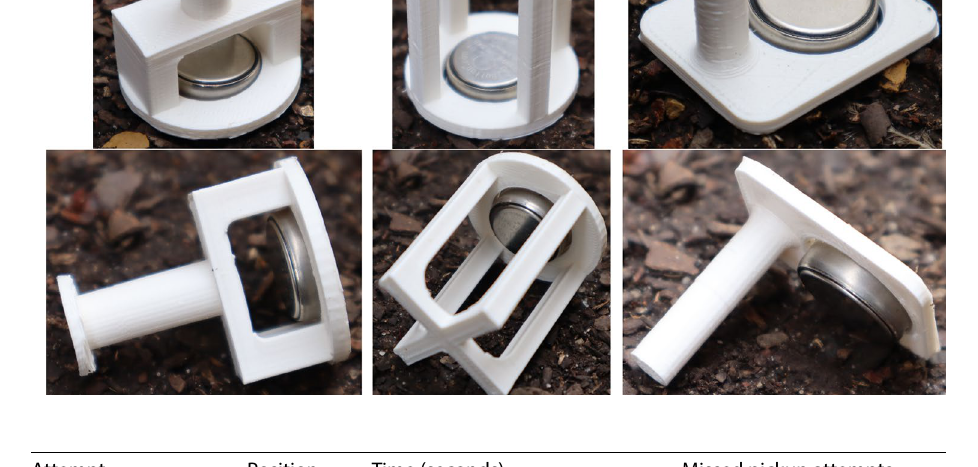
Table 5 Testing of gripper and sensor holder effectiveness